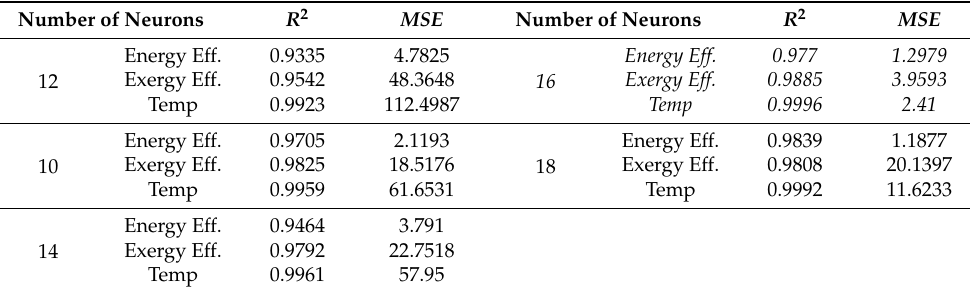
Table 3. The results of ANN